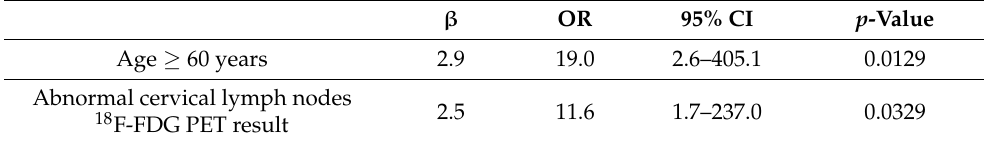
Table 6. Logistic regression analyses to determine factors associated with monocyclic evolution. β